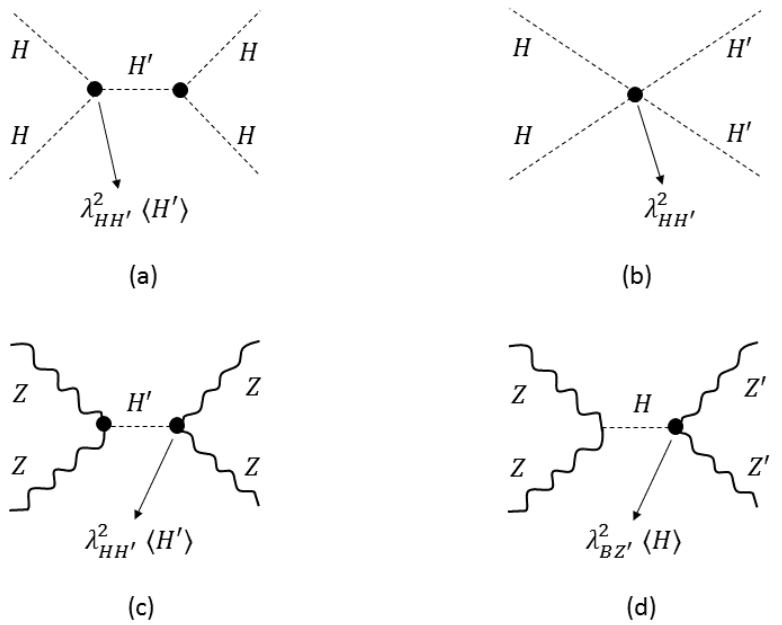
Figure 4. Basic search channels for the BSM scalars H (cid:48) ( a , b ) and BSM vectors V (cid:48) µ ( c , d ). (taken from Reference [29]).